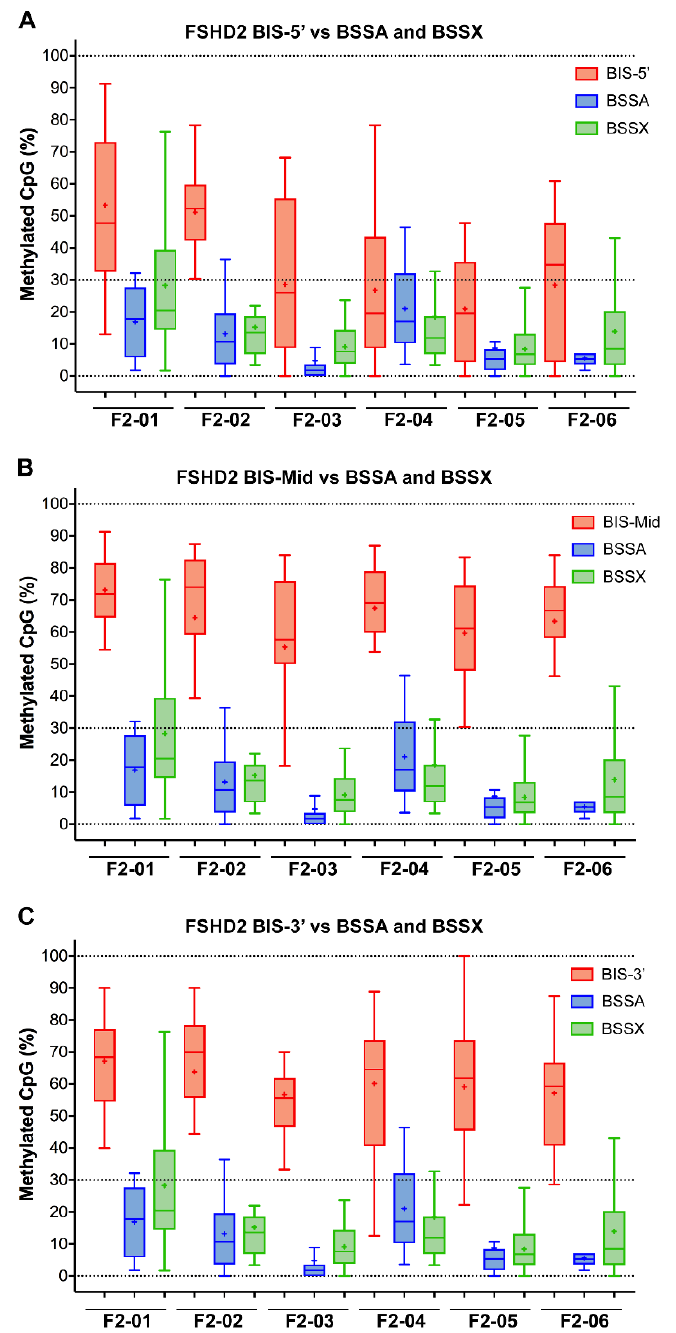
Figure 5. Box plots showing the percentage of CpGs analyzed for each single BSS read for each individual FSHD subject comparing the three BIS assays to the BSSA and BSSX assays. ( A ) The BIS-5′ assay (red) is compared with the BSSA (blue) and BSSX (green) assays. ( B ) The BIS-Mid assay (red) is compared with the BSSA (blue) and BSSX (green) assays. ( C ) The BIS-3 (cid:48) assay (red) is compared with the BSSA (blue) and BSSX (green) assays. The box extends from 25 to 75 percentiles with whiskers showing the smallest and largest value. The bar in the box is the median and the + is the mean for each